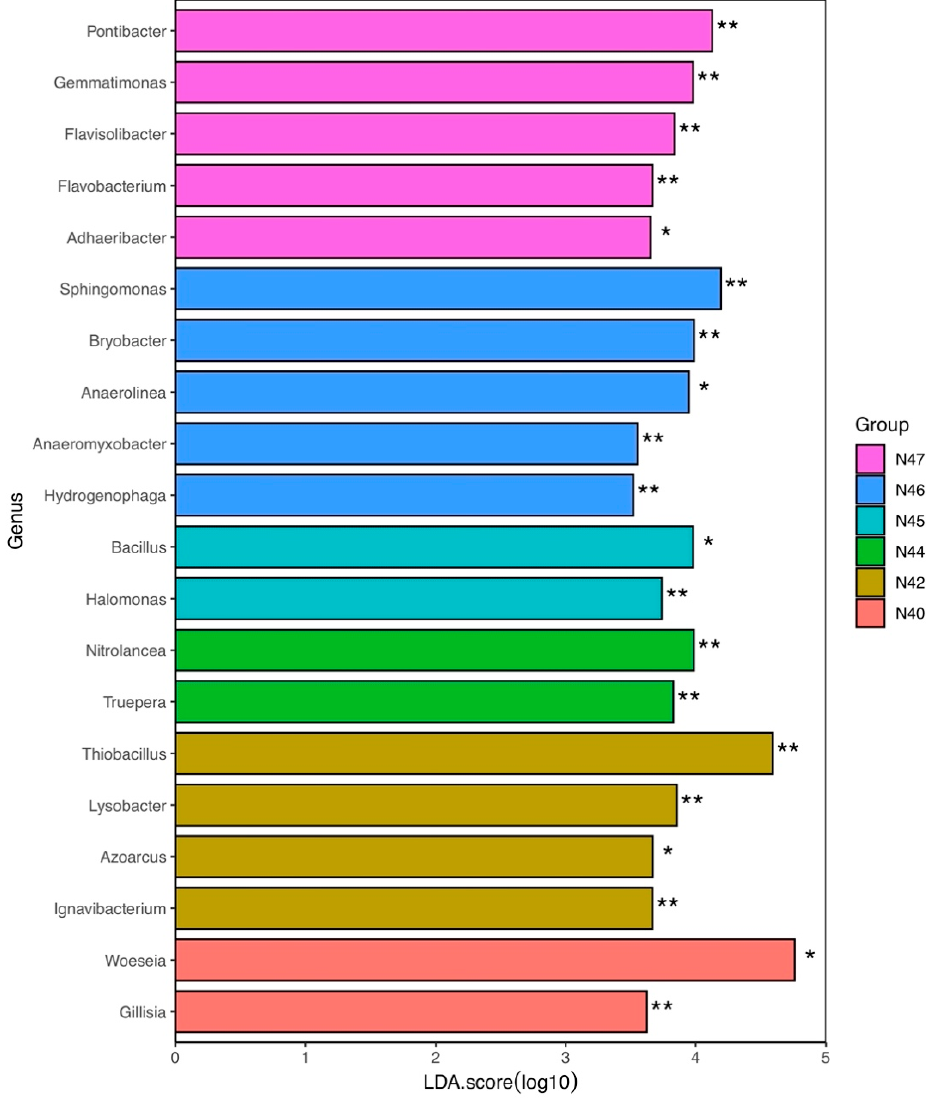
Figure 7. Difference in the bacterial community composition based on linear discriminant analysis effect size (LEfSe). Wilcoxon signed-rank test, Kruskal–Wallis H test, and linear discriminant analysis (LDA) were performed for determination of the OTU groups that most likely explain the differences between samples. The statistical significance of the effect is indicated by * p < 0.05 and ** p < 0.01.